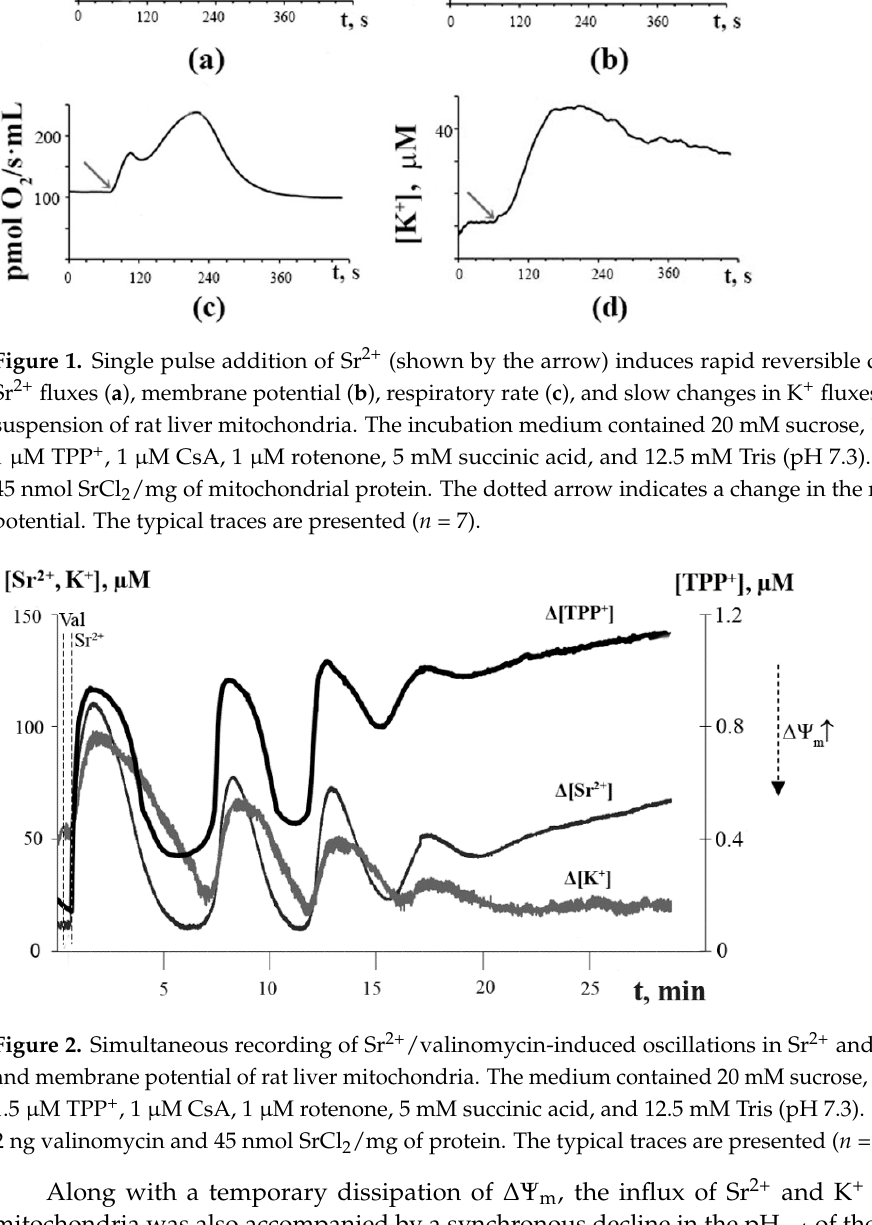
Figure 3. Sr 2+ /valinomycin-induced cyclic changes in matrix volume of rat liver mitochondria. The experimental conditions were the same as in Figure 2. Additions: 2 ng valinomycin and 45 nmol SrCl 2 /mg of protein. The typical traces are presented ( n = 5).